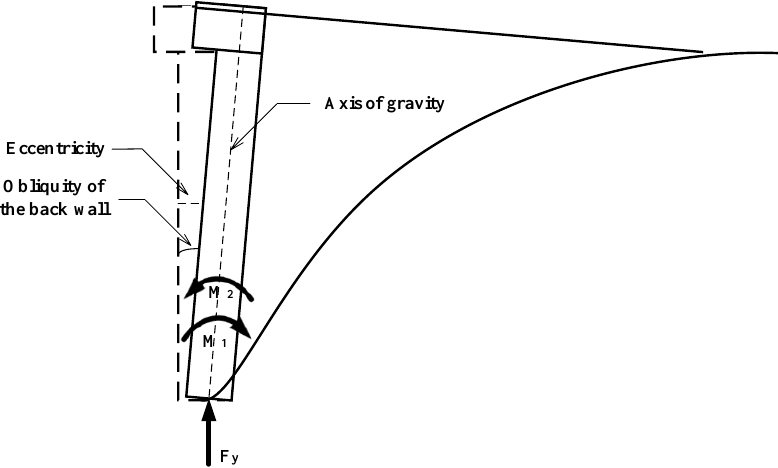
Figure 14. Overturning moment calculation.